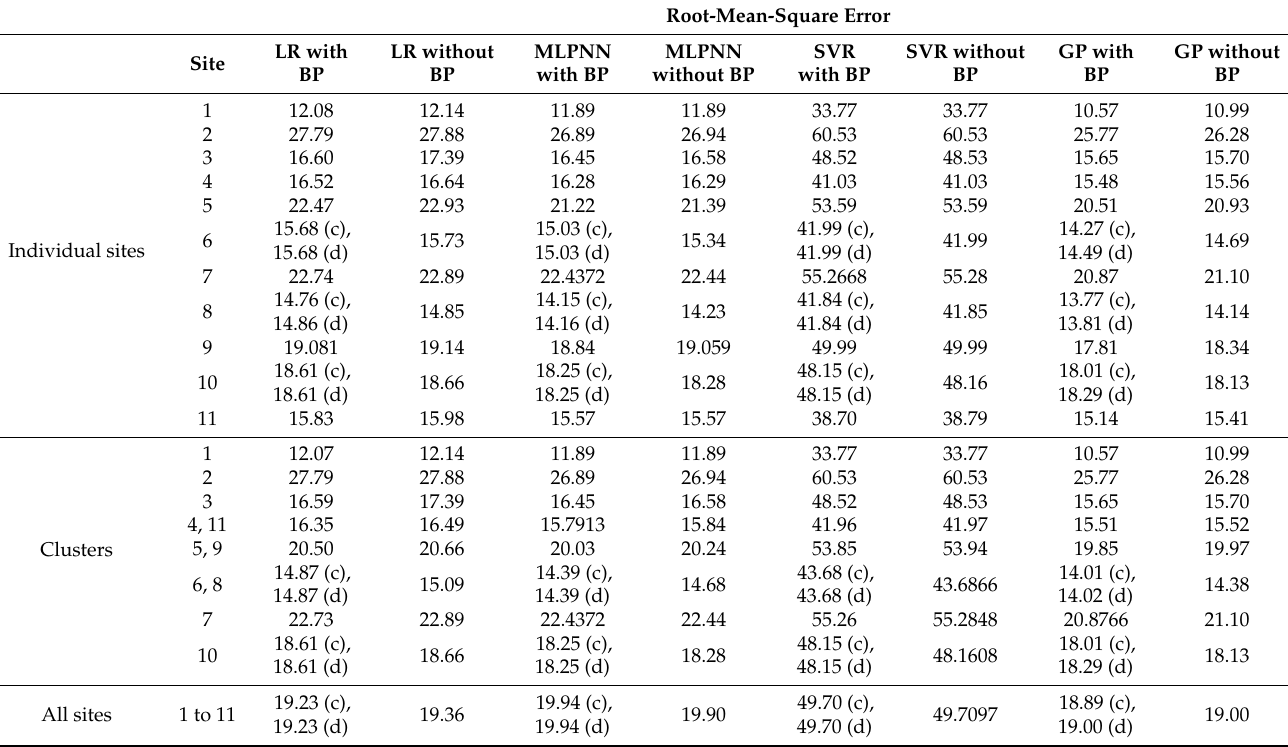
Table 8. RMSEs at the 1 h interval on each